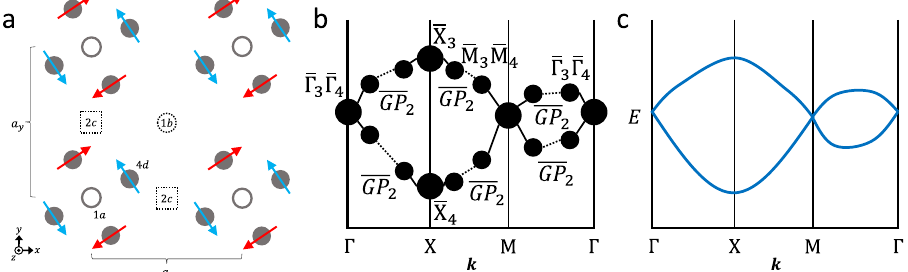
Fig. 3 Magnetic band (co)reps from magnetic atomic orbitals. a A crystal with lattice-commensurate magnetic order. In the mean- fi eld, the basis states of the electronic Hamiltonian of the crystal in ( a ) are magnetic atomic orbitals (SN 18). When weakly coupled, the magnetic atomic orbitals in ( a ) continue to form a set of exponentially localized, symmetric Wannier orbitals 5,15,16,53 that transform in the (co)reps of magnetic site-symmetry groups [SN 7]. b The magnetic site-symmetry (co)reps in ( a ) induce a band (co)rep in momentum [ k ] space. c Correspondingly, the Bloch eigenstates of the Fourier- transformed electronic Hamiltonian of the magnetic crystal in ( a ) transform in the band (co)rep in ( b ) [see SN